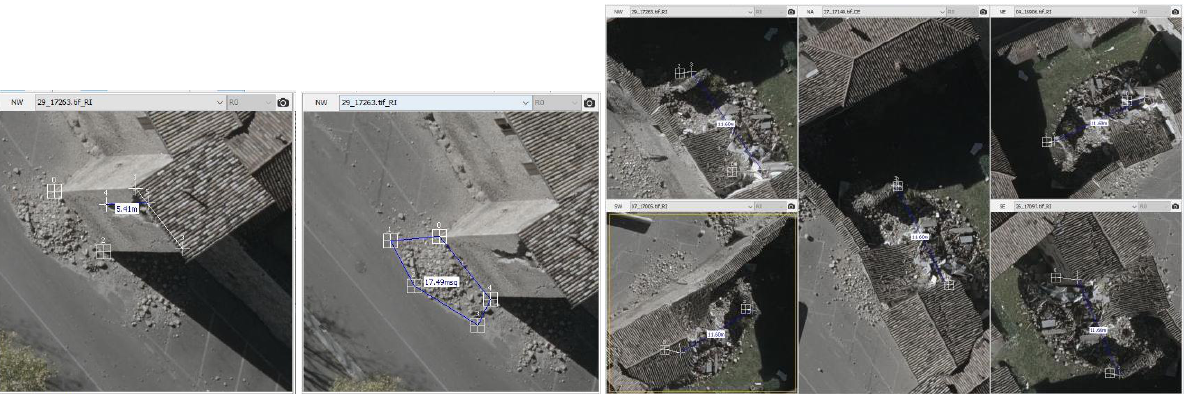
Figure 11. Examples of distance and area measurements in semi-oblique images within